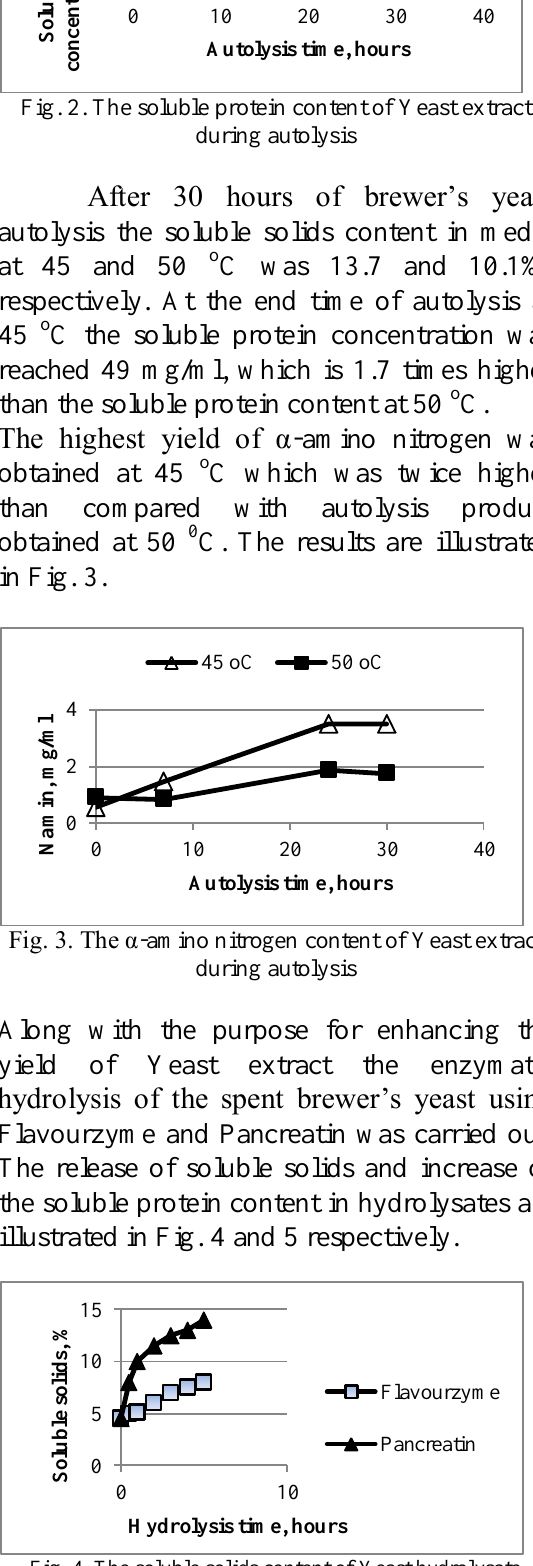
Fig. 4. The soluble solids content of Yeast hydrolysate